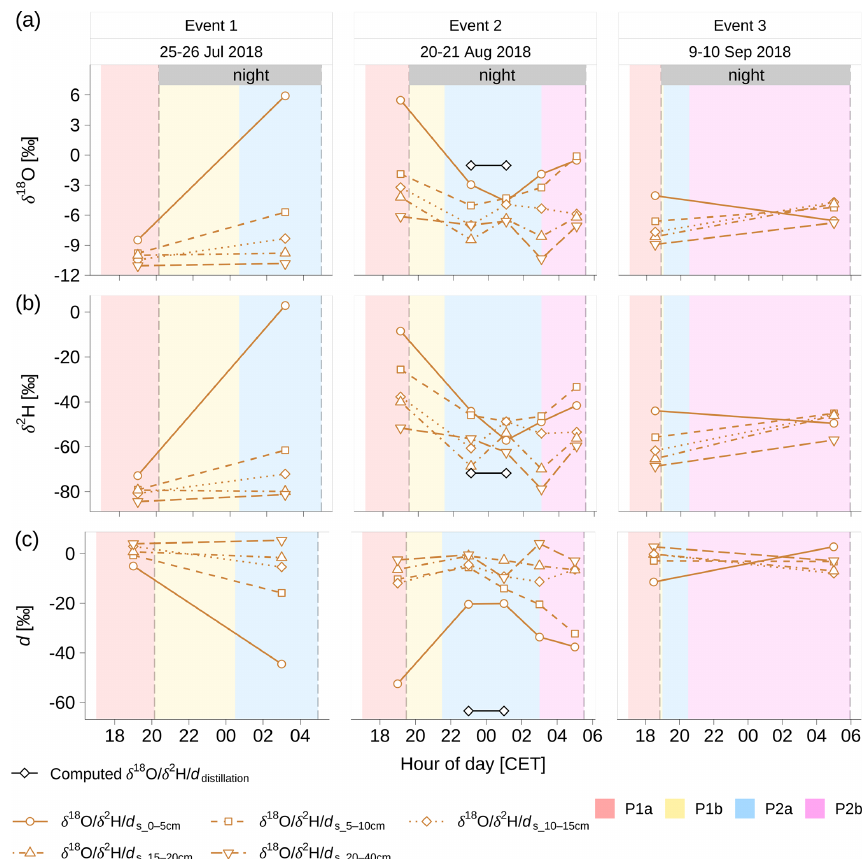
Figure 8. The isotopic composition of soil moisture ( δ 18 O s and δ 2 H s ) at 0–5, 5–10, 10–15, 15–20, and 20–40cm as compared to the isotopic composition of distillation ( δ 18 O distillation and δ 2 H distillation ) computed from the two-end-member mixing model. Vertical dashed lines show local sunset and sunrise times. The shaded areas indicated different periods of environmental conditions as described in Sect. 4.1. The P1a period was from around 17:00CET until sunset with the weakening of turbulence and the increase of specific humidity; the P1b period was from sunset until the first sign of condensation with short-term fluctuations of specific humidity; the P2a period was the dew formation period in the conditions of relative humidity < 100%; the P2b period was the combined dew and radiation fog period in the conditions of relative humidity =